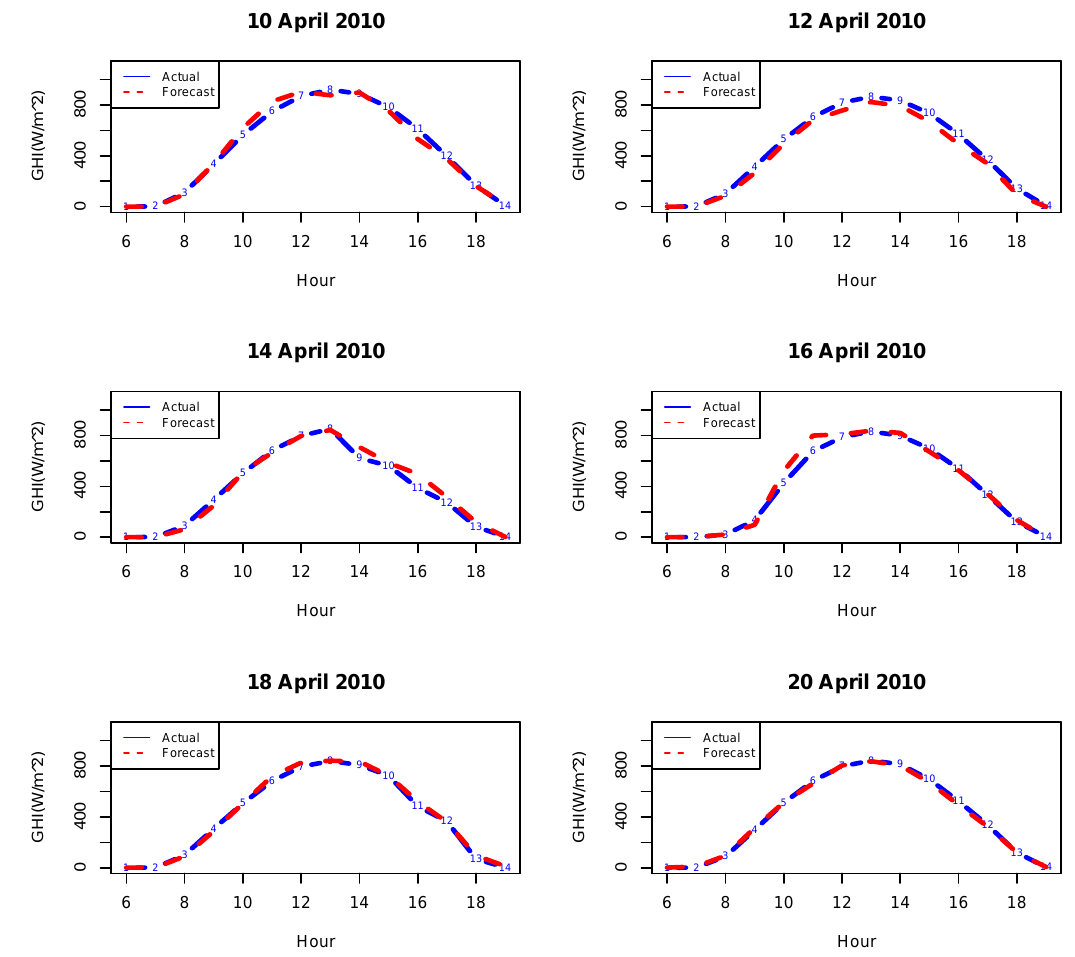
Figure 8. Actual and predicted GHI for some selected days of April